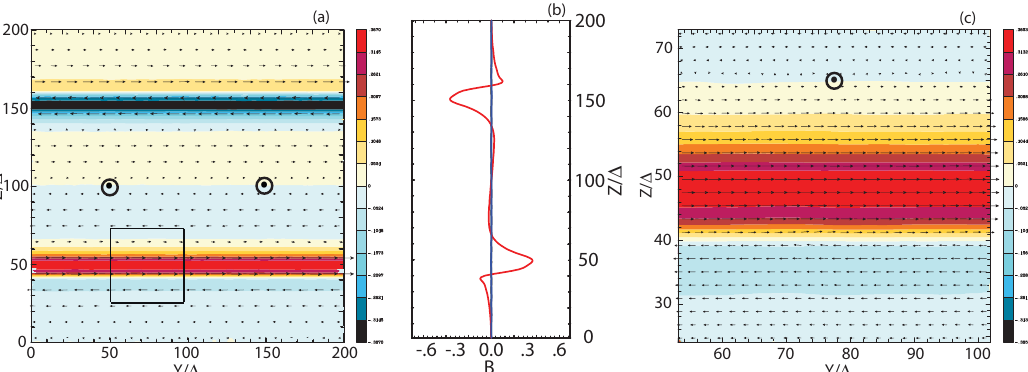
Figure 4. Magnetic field structure transverse to the flow direction for γ jt = 15 is shown in the y − z plane (jet flows out of the page) at the center of the simulation box, x = 500 ∆ for the e − − p + case. The small arrows show the · magnetic field direction in the transverse plane (the arrow length is not scaled to the magnetic field strength). 1D cuts along the z axis of magnetic field components B x (black), B y (red), and B z (blue) are plotted at x = 500 ∆ and y = 100 ∆ for ( b ) the e − − p + case. Note that the magnetic field strength scales in panels ( a ) ( ± 0.367) are different. An enlargement of the shear surface structure in the y − z plane contained within the squares in the left panels is shown in the panels ( c ) to the right. Adapted from Figure 6 in Nishikawa et al.